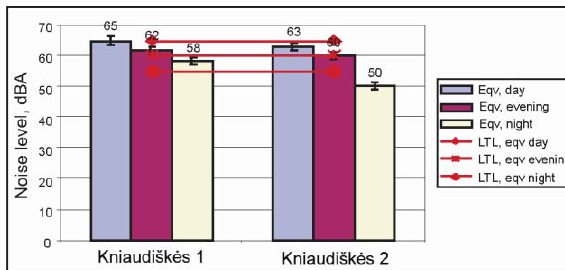
Fig. 28. Dynamics of equivalent noise levels in Kniaudiškės street within twenty four hours